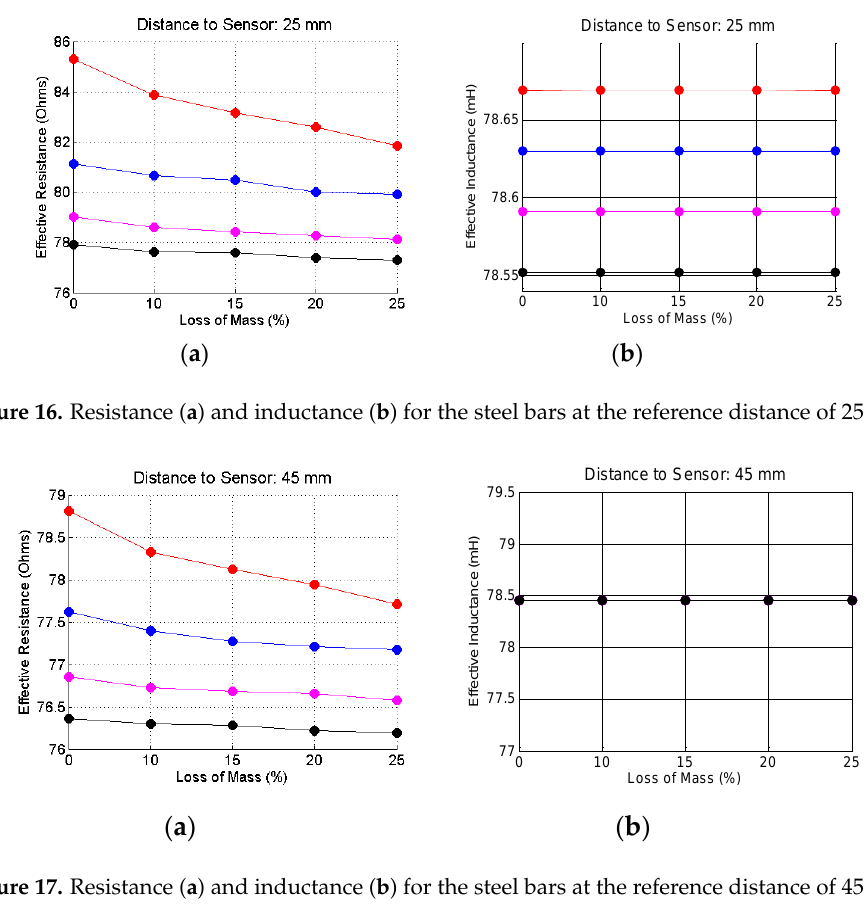
Figure 15. Resistance ( a ) and inductance ( b ) for the steel bars at the reference distance of 5 mm.